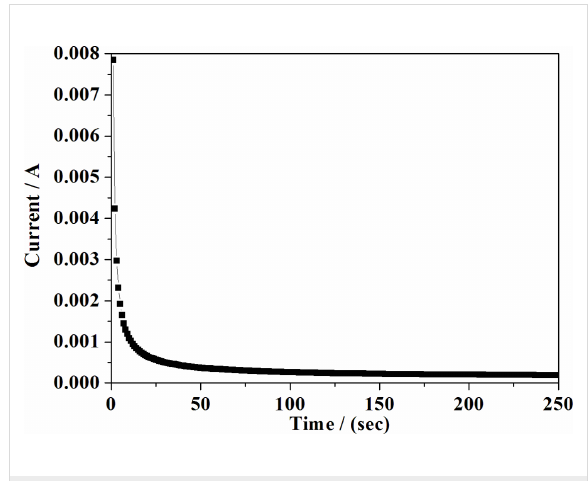
Figure 11: A dc polarization curve as a function of time for a polymer gel